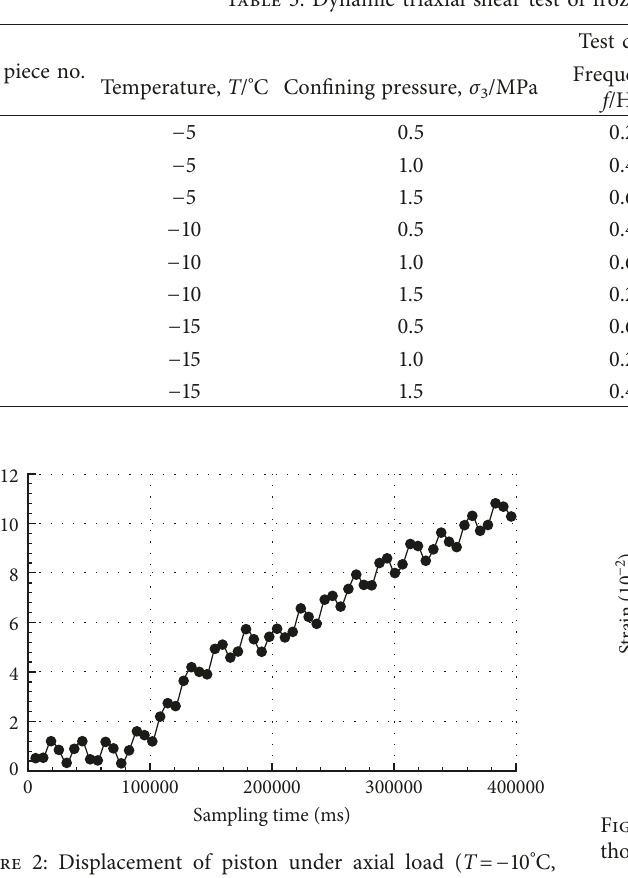
10 ° C, f 0.2Hz, σ 3 (cid:31) (cid:31) −